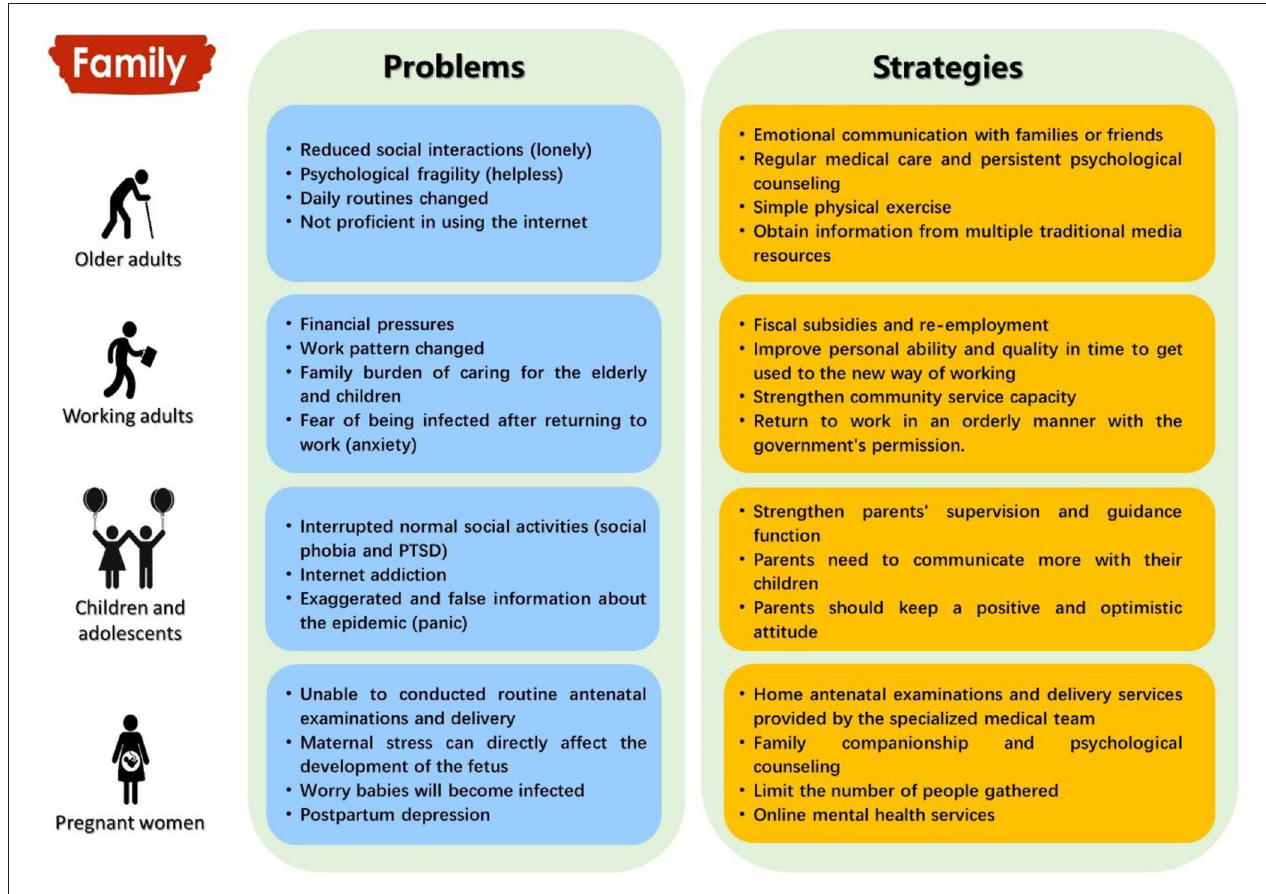
FIGURE 1 | Impacts of the COVID-19 pandemic on individuals’ mental health and corresponding strategies for mitigating these adverse effects among a stimulated ordinary family